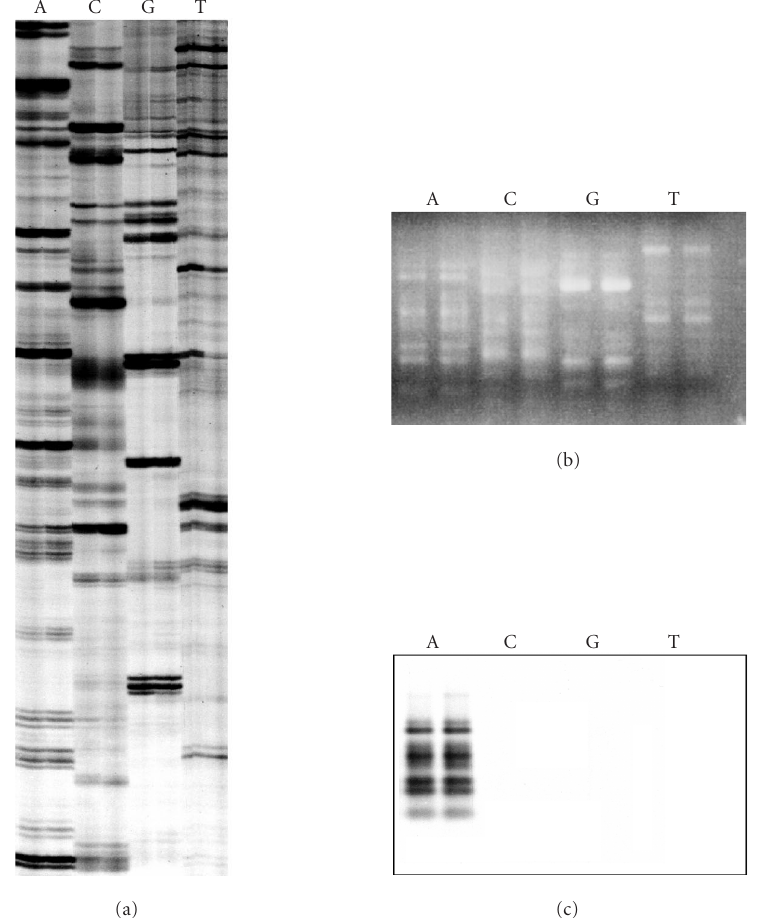
Figure 5. Selective amplification of RAF markers is dependent on the 3 (cid:3) nucleotide of the oligonucleotide primer. (a) Radio-labelled RAF profiles for sugarcane hybrid 79A362 using oligonucleotide primers K-02 (5 (cid:3) -GTCTCCGCAA-3 (cid:3) ) (lanes A), K-02a (5 (cid:3) -GTCTCCGCAC-3 (cid:3) ) (lanes C), K-02b (5 (cid:3) - GTCTCCGCAG-3 (cid:3) ) (lanes G), and K-02c (5 (cid:3) -GTCTCCGCAT-3 (cid:3) ) (lanes T). These primers only varied in the final 3 (cid:3) nucleotide. The profiles were amplified from replicate DNA extractions of sugarcane 79A362. (b) Identical reactions, also in replicate, were produced without radio-labelling, separated on a 2% agarose gel, ethidium-bromide stained, and photographed. (c) The unlabelled RAF fragments were then blotted from the agarose gel onto a nylon membrane and probed with radio-labelled RAF products amplified with K-02 (lanes A in panel